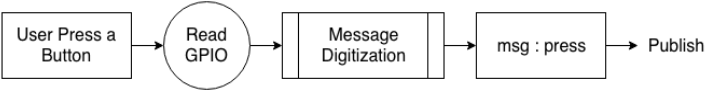
Figure 7. User’s action digitisation.